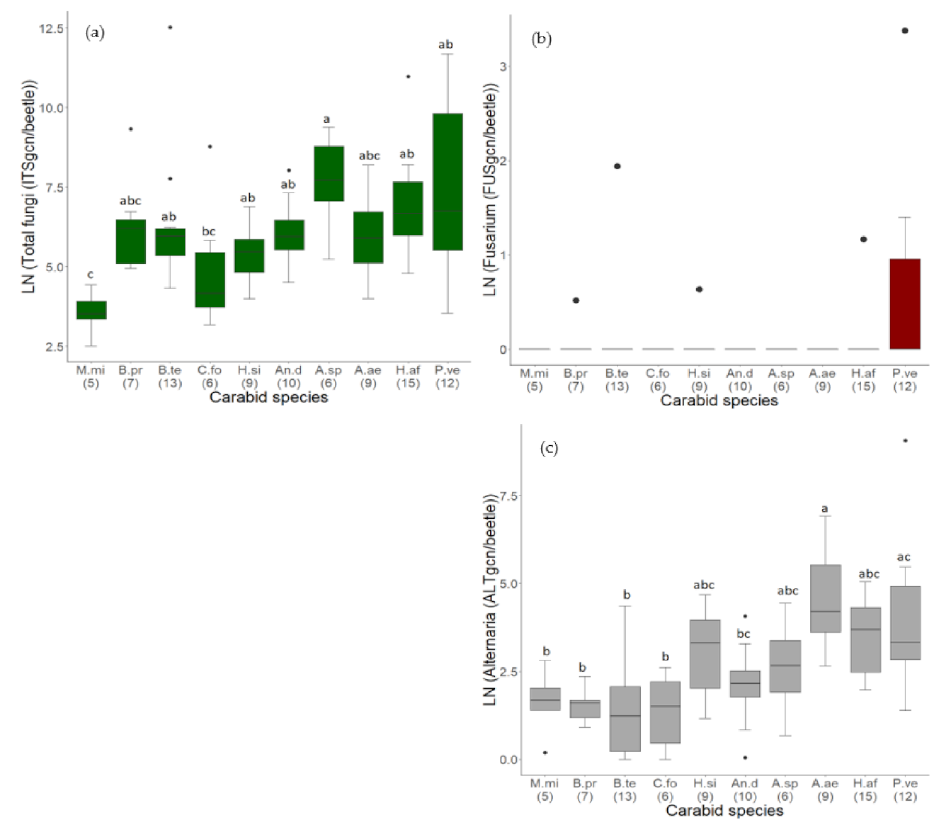
Figure 5. Load of fungal DNA (genome copy numbers, gcn) in samples of carabid beetles compris- ing the body surface and inner body parts. All data was LN(x + 1)-transformed. ( a ) Total fungi (ITSgcn/beetle), ( b ) Fusarium (FUSgcn/beetle) and ( c ) Alternaria (ALTgcn/beetle). The number of samples per species is given in brackets and carabid species are sorted from the lightest to the heaviest. Significant differences between species are indicated with a, b, or c. Species code according to Table 2 (abbreviations short). Black dots in the boxplots are outliers or only one observation per carabid species in ( b